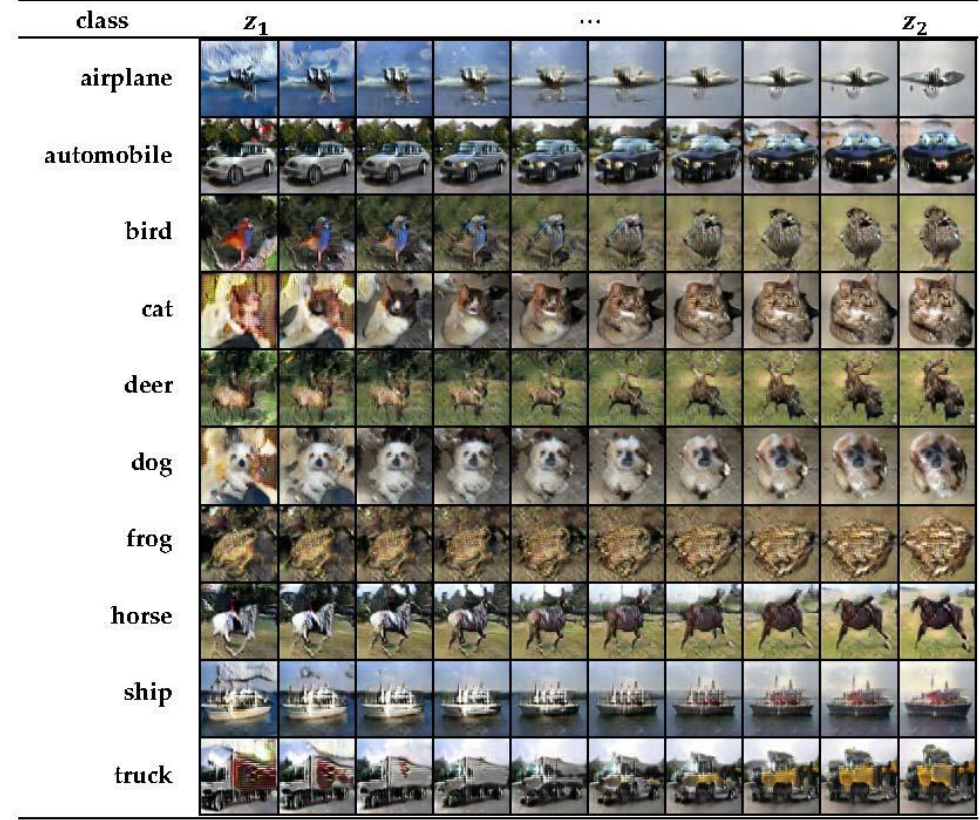
Figure A1. The interpolation images between two latent vectors. This image is generated by HRGAN-128 and down-sampled to the size of 64 × 64.